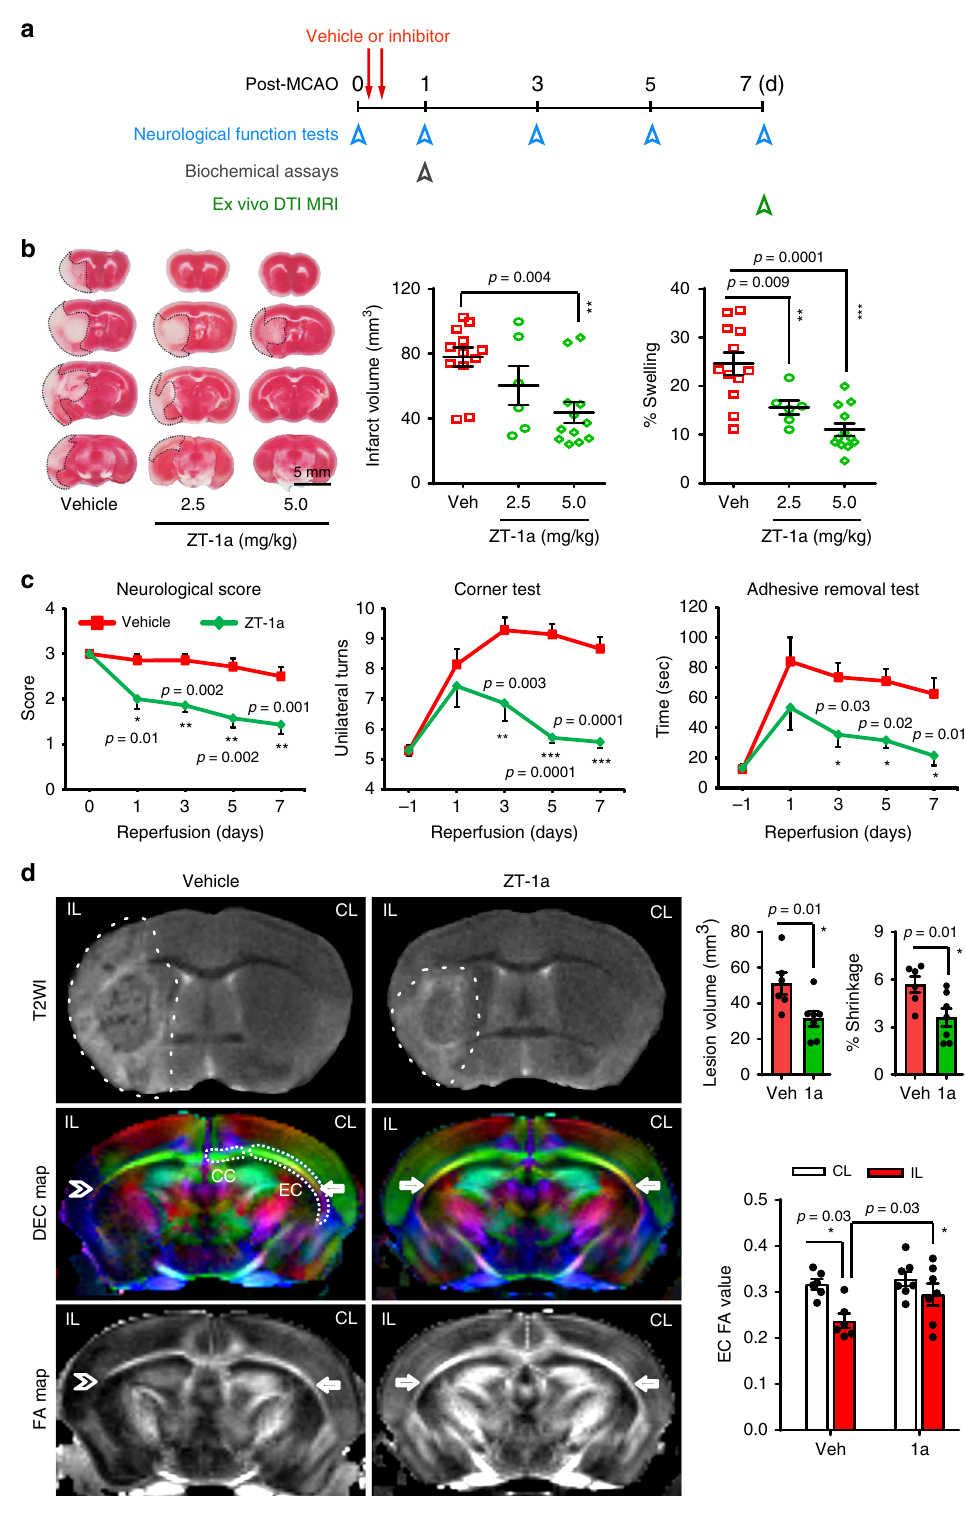
introduction of STOCK1S-50699 and STOCK2S-26016 70 has highlighted SPAK inhibitors that target the CCT domain rather than the kinase domain. However, only STOCK1S-50699, but not STOCK2S-26016, suppressed in vitro phosphorylation of SPAK/ OSR1 and NKCC1 induced by hypotonic low [Cl − ] 25 . Moreover, in vivo pharmacokinetics of STOCK1S-50699 are unfavorable (data not shown). The livestock antiparasitic drug, Closantel 71 ,